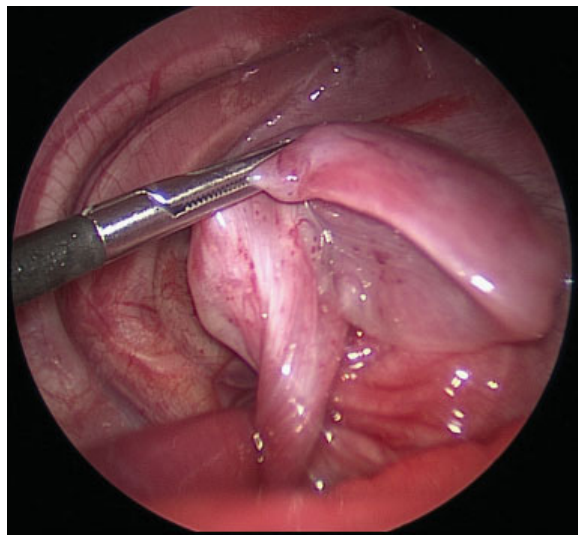
Fig. 1 Extralobar sequestration with its feeding artery.